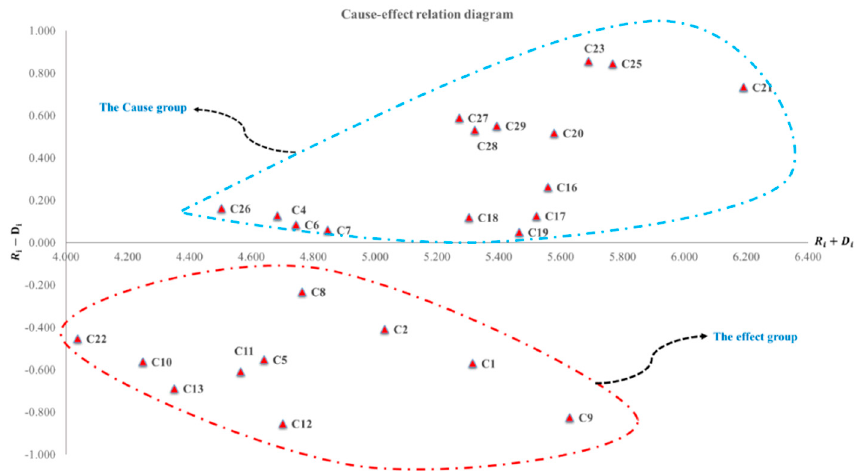
Figure 2. Cause-effect strategy map.